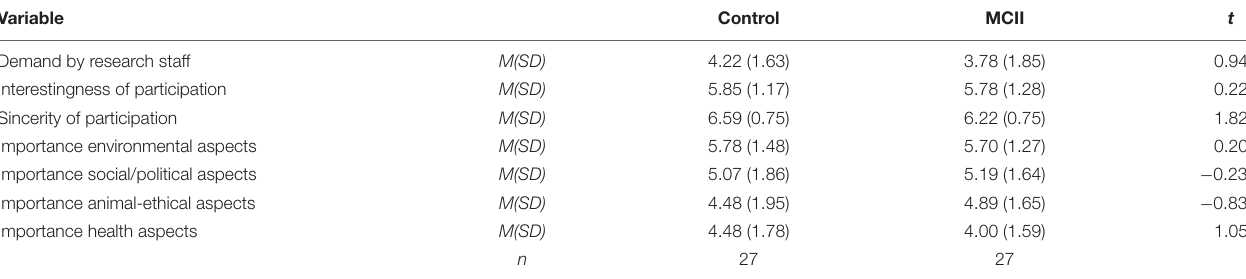
TABLE 3 | Means and standard deviations of additional variables in the control and MCII condition.